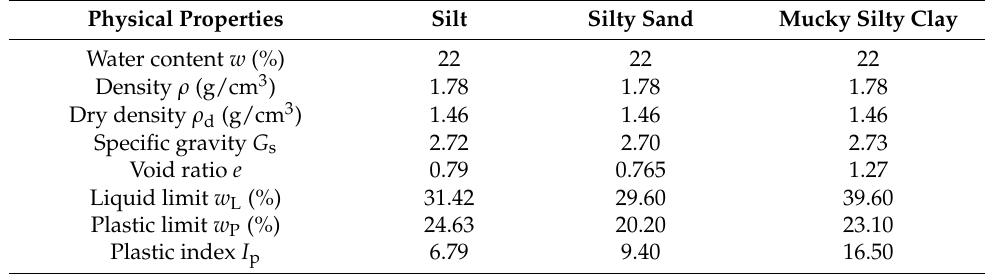
Table 2. Physical properties of